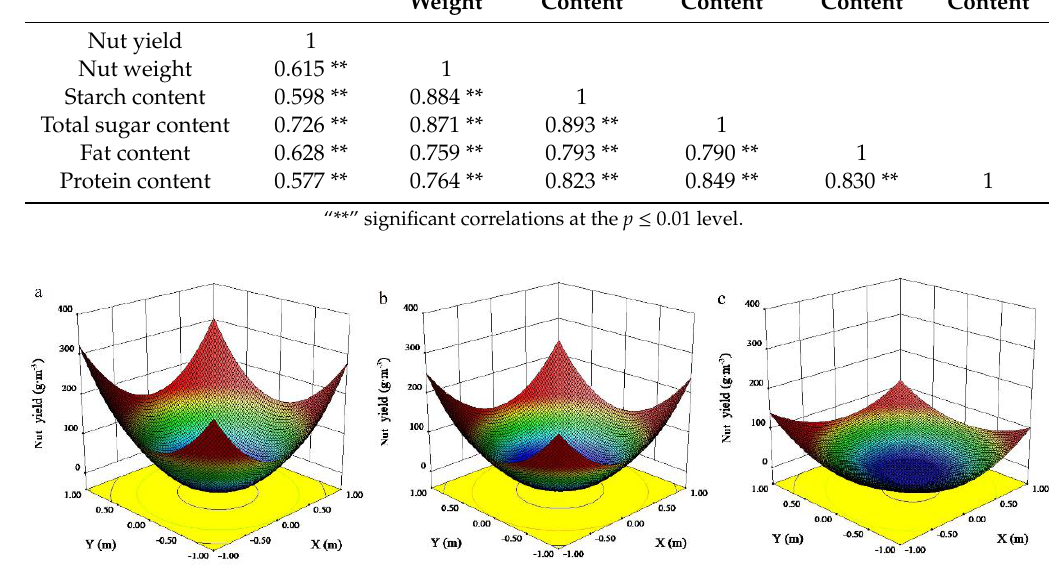
Figure 3. Distribution of nut yields in the different layers. The x -axis shows the distance in the east (+) and west (−) directions from the trunk. The y -axis shows the distance in the south (+) and north (−) directions from the trunk. The z -axis represents the nut yield. ( a ) Top layer; ( b ) middle layer; ( c ) lower layer.